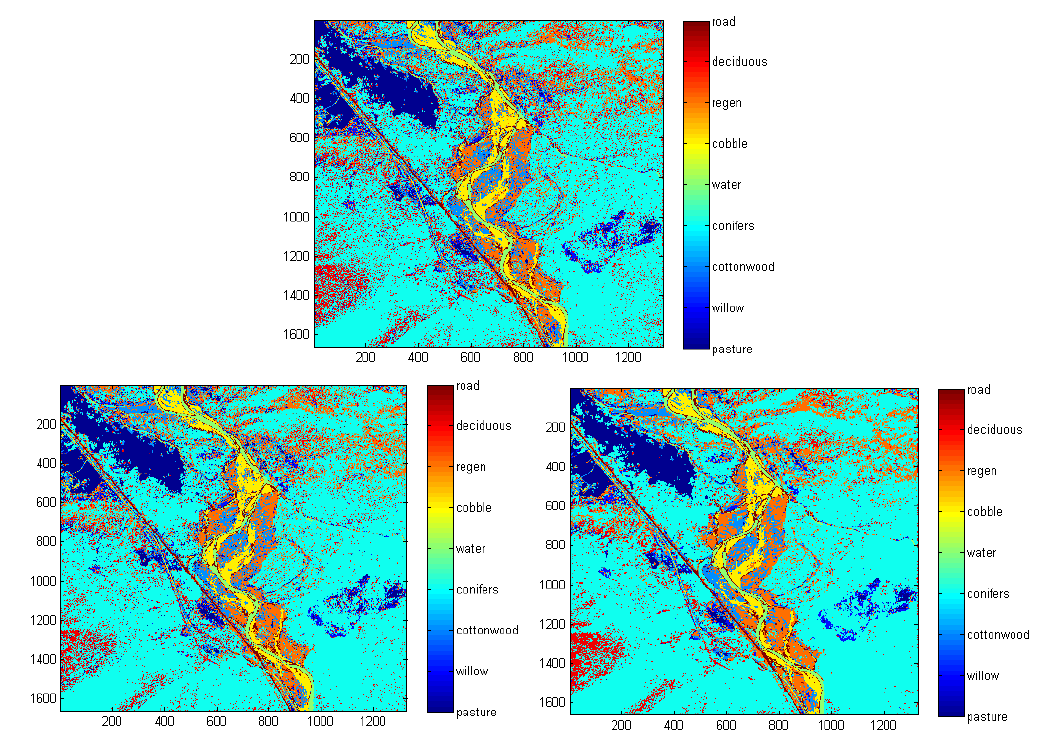
Figure 2. ( Above ) is the QDA classification. The lower figures are the classifications obtained using probability label relaxation ( left ) and Markov random fields ( right ), respectively, applied to the QDA